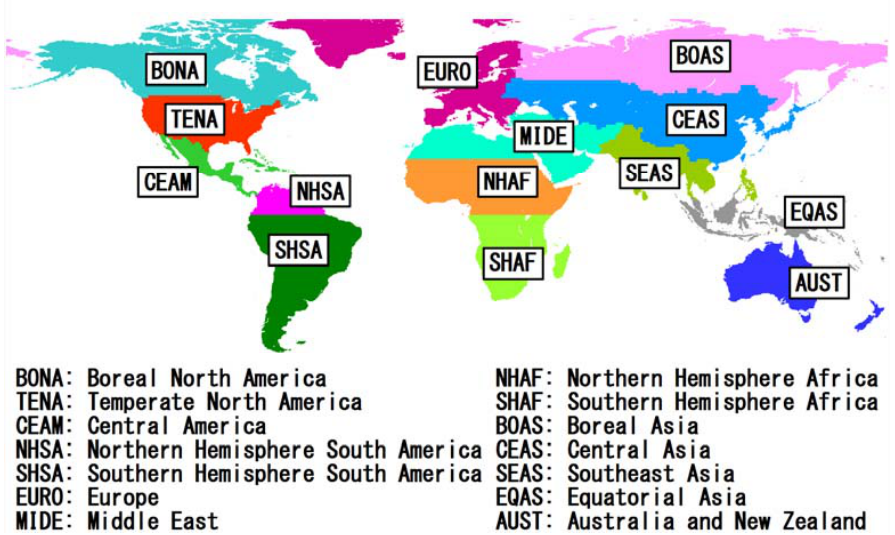
Figure 1. Spatial distribution map for the 14 evaluation regions, according to van der Werf et al. (2006) [4]. Map was created with ArcGIS version 10.5 (https://www.arcgis.com/ (accessed on 12 March 2021)).